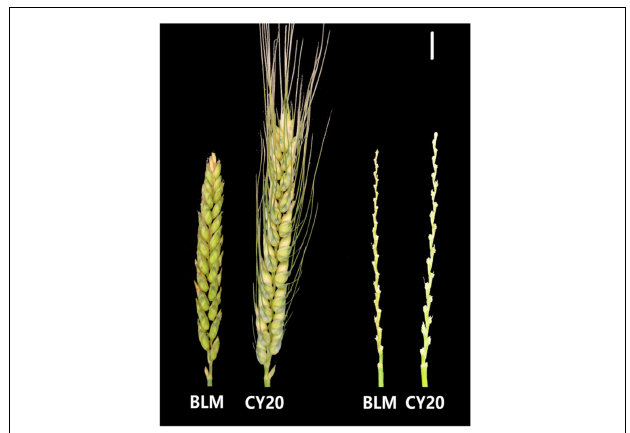
FIGURE 1 | Spike morphology of the parental lines BLM and CY20 growing in the Shuangliu region (2019–2020 growing season). The bar represents 1